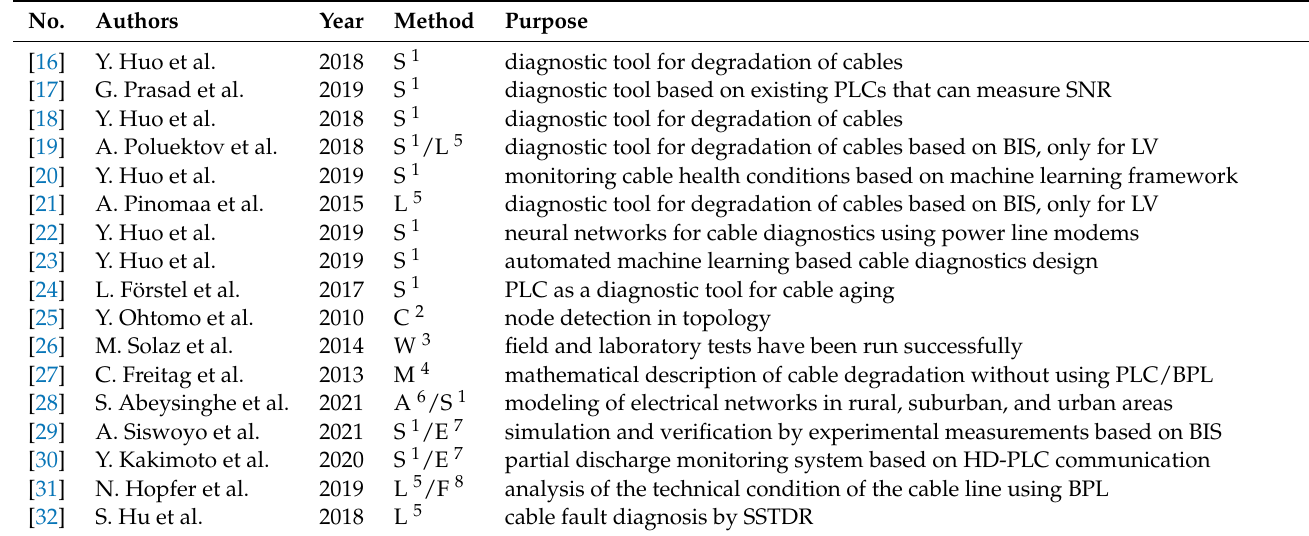
Table 1. State of the art.